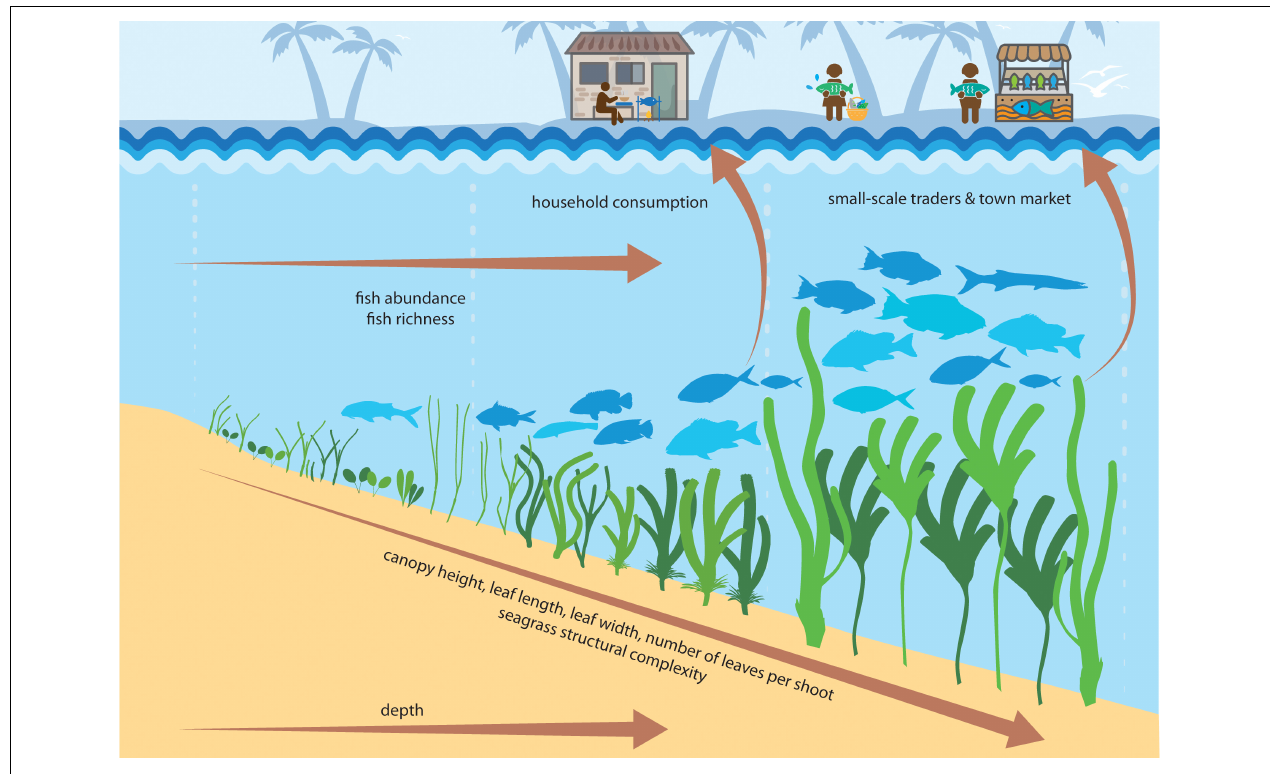
FIGURE 7 | Conceptual diagram showing how seagrass structural complexity influences seagrass social-ecological systems. Seagrass meadows with taller canopies, longer and wider leaves and more numerous leaves per shoot have greater fish abundance and richness, and in particular support species of value to small-scale